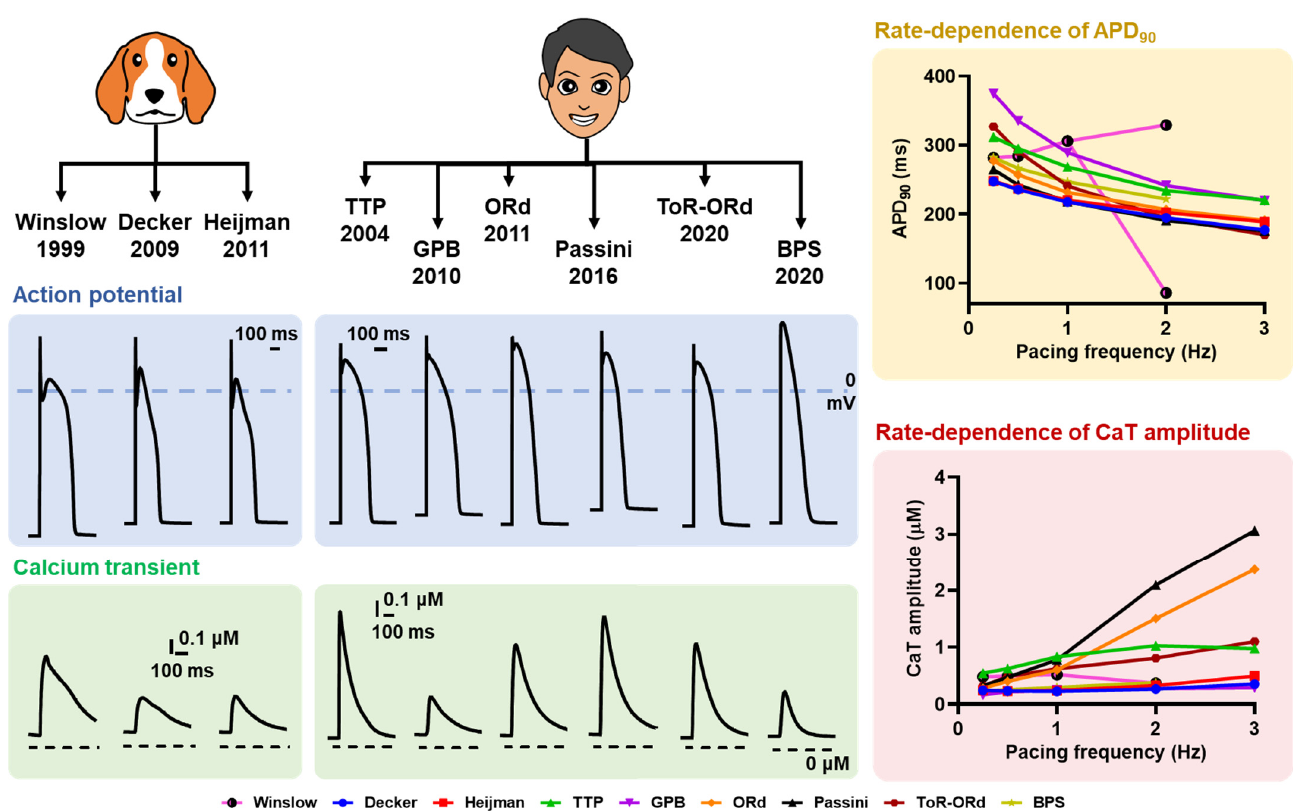
Figure 5. Comparison of APD and calcium transient (CaT) between several canine and human ventricular cardiomyocyte models. The AP and CaT were stimulated using the default setting of each model at a 1 Hz pacing frequency (basic cycle length [BCL] of 1000 ms; the left panels) and quasi-steady-state was obtained following 1000 beats of pre-pacing. (BPS model = [60]; Decker model = [21]; GPB model = [61]; Heijman model = [62]; ORd model = [52]; Passini model = [63]; ToR-ORd model = [64]; TTP model = [65]; Winslow model =